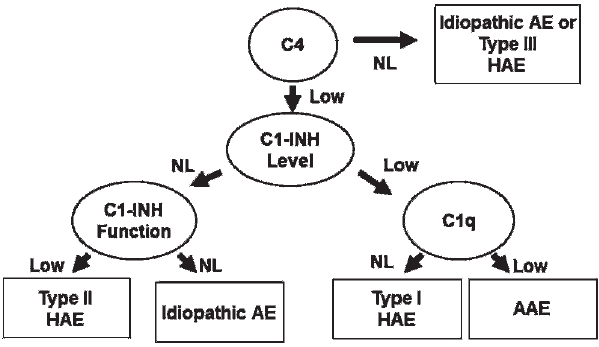
Figure 1 - Diagnostic algorithm of hereditary angioedema. C1- INH: C1 inhibitor, HAE: hereditary angioedema, AAE: acquired angioedema, NL: normal.